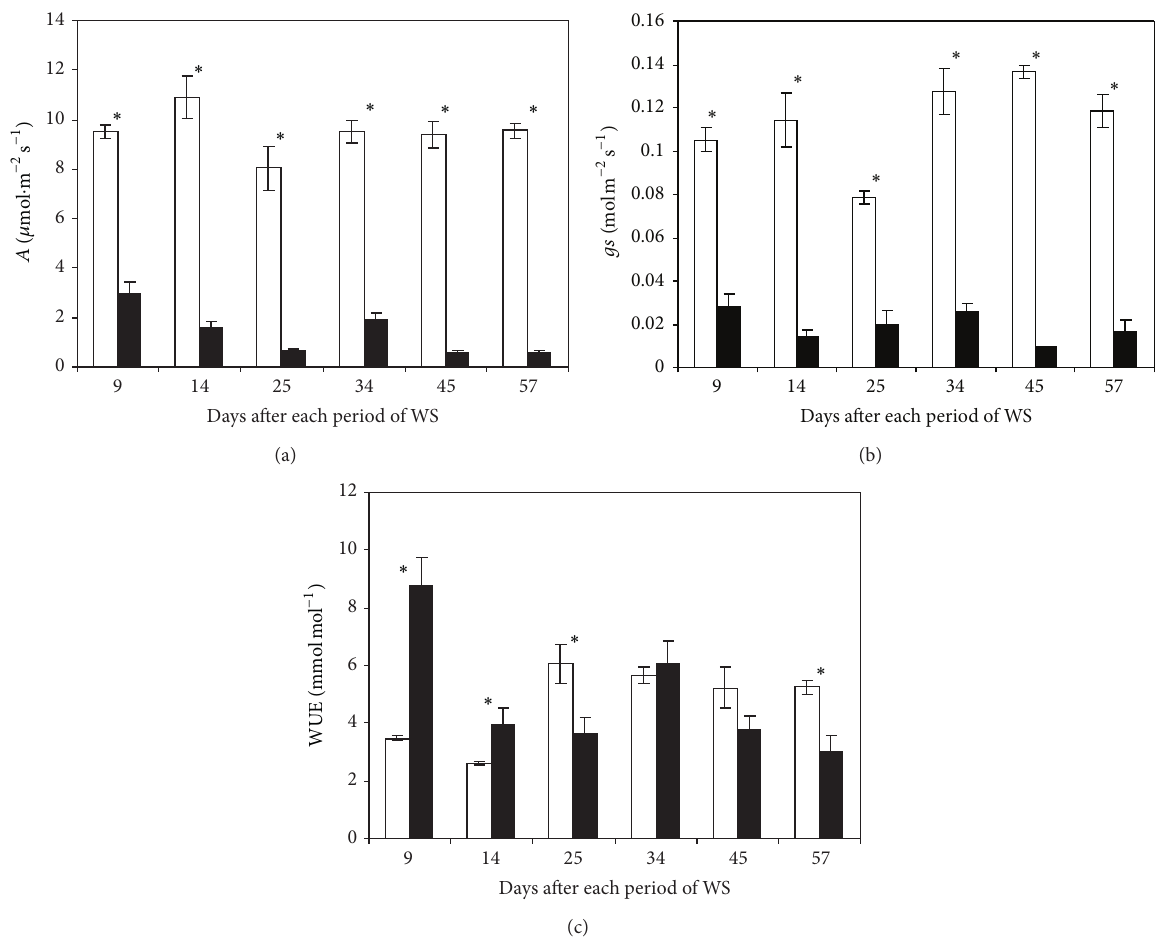
Figure 5: Photosynthetic rate (𝐴) , stomatal conductance (gs), and water use efficiency (WUE) in fully expanded leaves of banana plants. Treatments were regularly irrigated ( ◻ ) and water-stressed ( ◼ ) banana plants. Data are means ± SE and each value was determined in three different plants with three replicates per treatment (𝑛 = 9) . Data were compared for each date using the least significant difference (LSD) test. Significant differences at 𝑃 ≤ 0.05 are represented by an asterisk ( ∗ ). WS: water